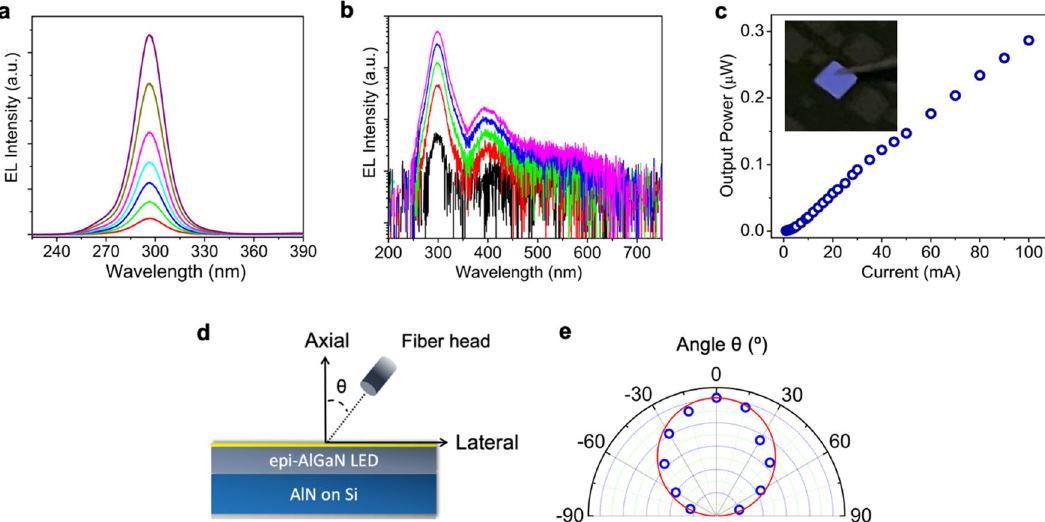
Figure 4. ( a ) Room-temperature EL spectra of an AlGaN DH LED under different injection currents. ( b ) Room-temperature EL spectra taken up to the visible spectral range with currents varying from 1 to 12 mA. ( c ) Light output power versus the injected current. The inset shows an optical image of the light emission. ( d ) Schematic of the setup for the angle dependent EL measurement. ( e ) Emission pattern with the detection angle θ varying from − 75° to 75°. The solid curve denotes the ideal Lambertian pattern. Device size: 1 mm × 1